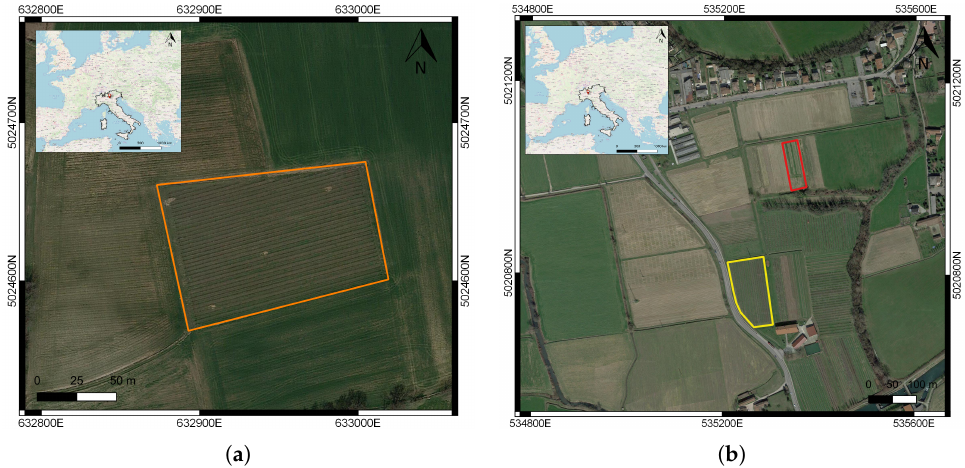
Figure 1. The experimental sites: ( a ) the vineyard; ( b ) in yellow the pear orchard and in red the tomato field. Coordinate Reference System (CRS): WGS84/UTM Zone 32N. Map data: c (cid:13) OpenStreetMap